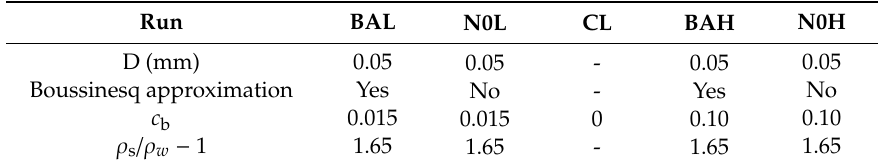
Table 1. Conditions of numerical